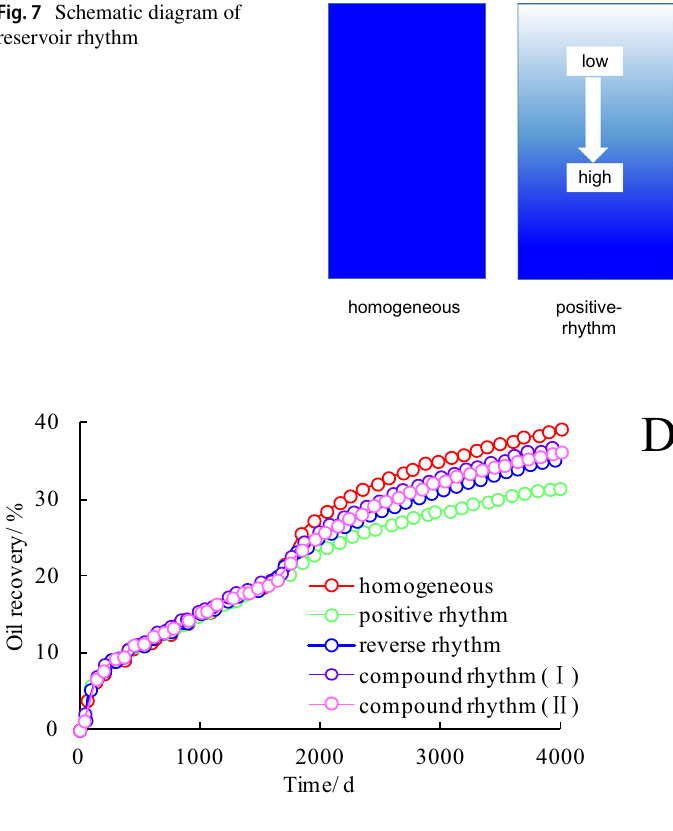
Fig. 7 Schematic diagram of reservoir rhythm